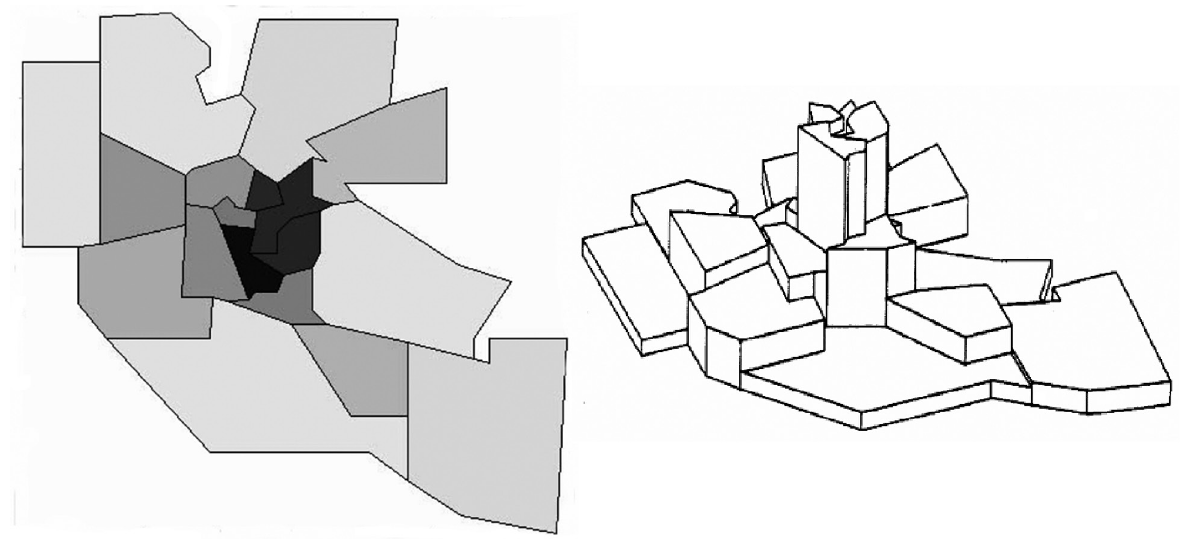
Fig. 1. Ann Arbor population as (left) choropleth map and (right) bivariate histogram in